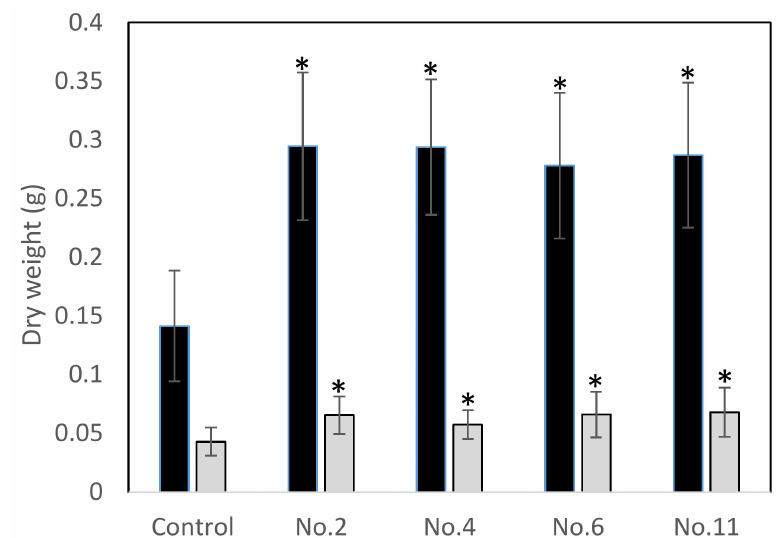
Figure 2. Growth response of Brassica campestris with plant growth-promoting bacteria selected in this study. Control ( n = 7), strain number 2 ( n = 10), strain number 4 ( n = 10), strain number 6 ( n = 7), strain number 11 ( n = 10), Dunnett test ( p < 0.05). The vertical bar indicates the standard error. * indicates significance di ff erences between treatments when compared with the control ( p <